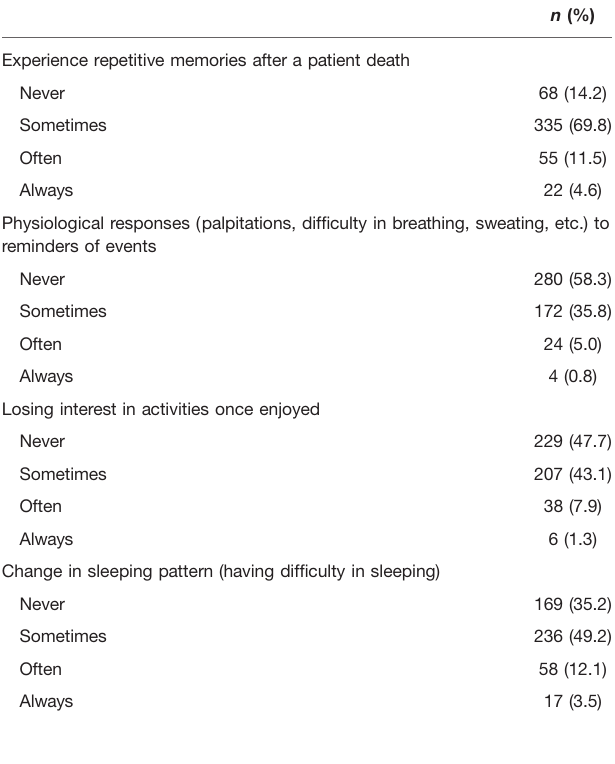
TABLE 2 | Impact of patient deaths on general surgeons.